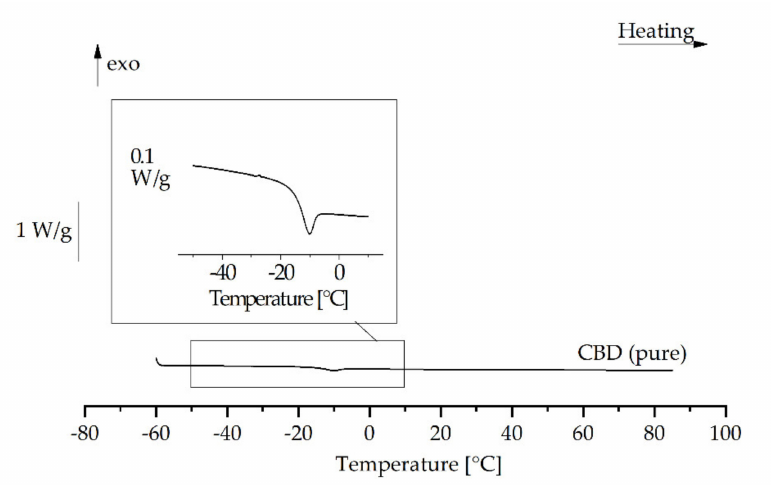
Figure 7. DSC reheating curve of cannabidiol (after heating to 85 ◦ C and subsequent cooling to − 60 ◦ C).